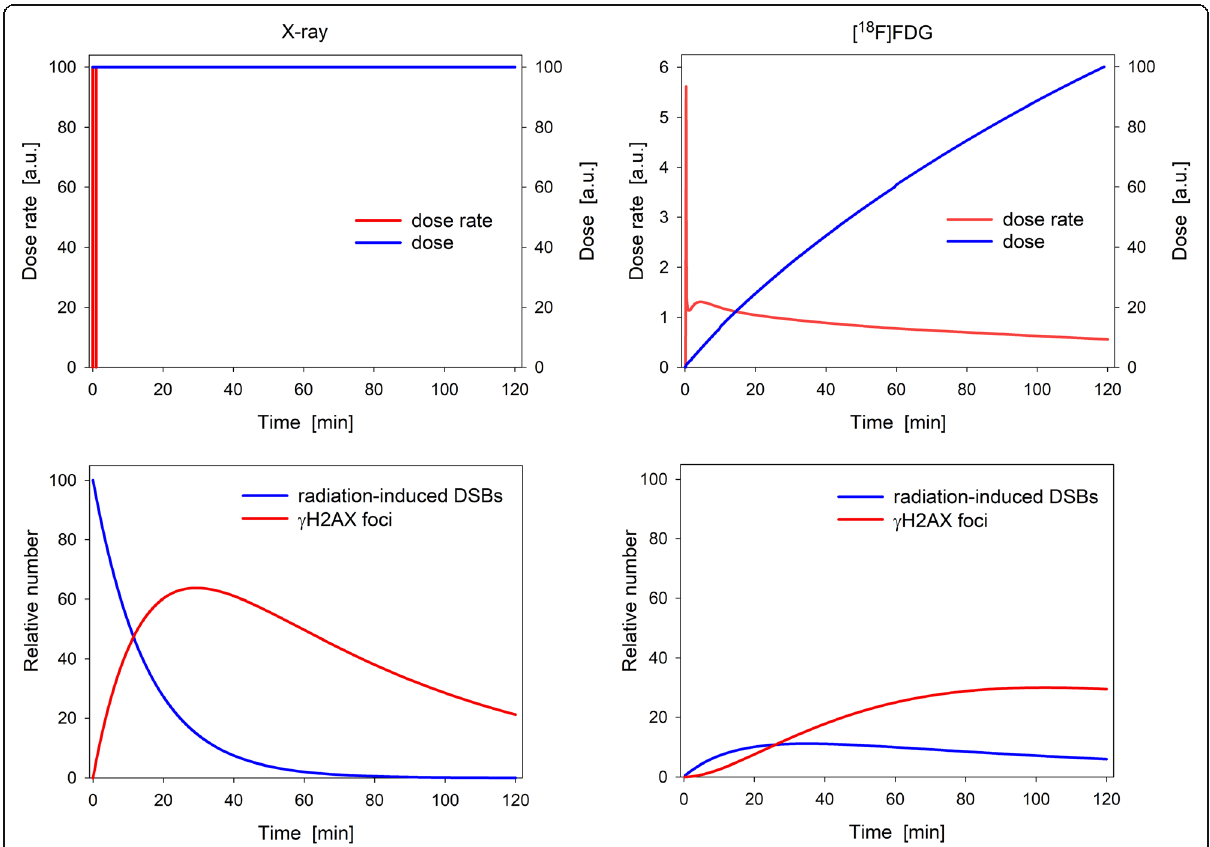
Fig. 1 Schematic representation of the differences between X-ray (left column) and radiotracer (right column) exposure on the formation and repair of DSBs monitored by the γ H2AX assay. The upper row compares the dose rate and the resulting absorbed dose to blood following a quasi-instantaneous X-ray exposure and [ 18 F]FDG administration (real data of a volunteer) assuming that the absorbed dose to lymphocytes is identical at the end of the considered time range. In the lower row, simulated kinetics of DSBs not yet under repair and of γ H2AX foci are plotted assuming that the maximum of foci rates occurs 30 min after X-ray exposure [17, 26, 27] and that the rate constants characterizing the formation and dephosphorylation of γ H2AX foci are comparable for both exposure scenarios. Prolonged exposure to [ 18 F]FDG results in a markedly delayed and flattened γ H2AX response at an overall lower